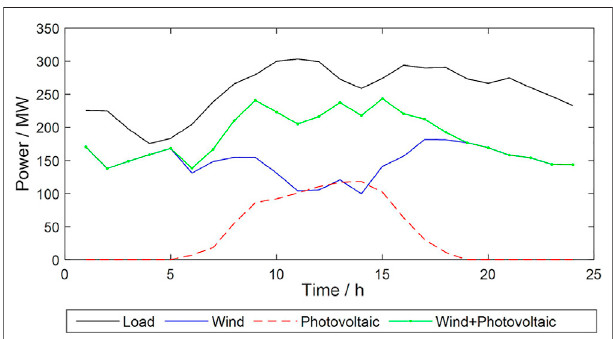
FIGURE 2 | Renewable energy forecast output and load curve.